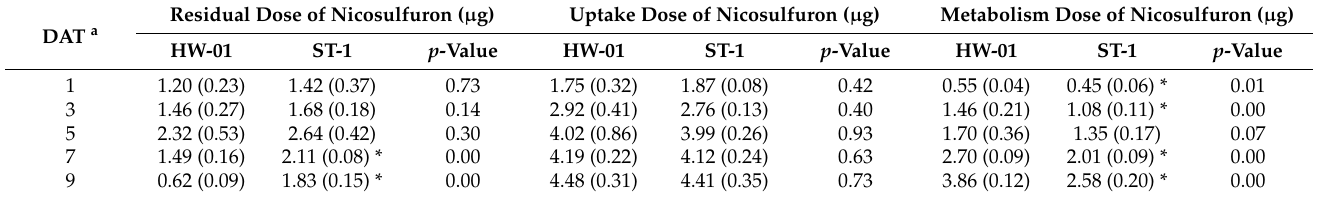
Table 6. Analysis of metabolic dynamics of nicosulfuron in A. retroflexus plants.